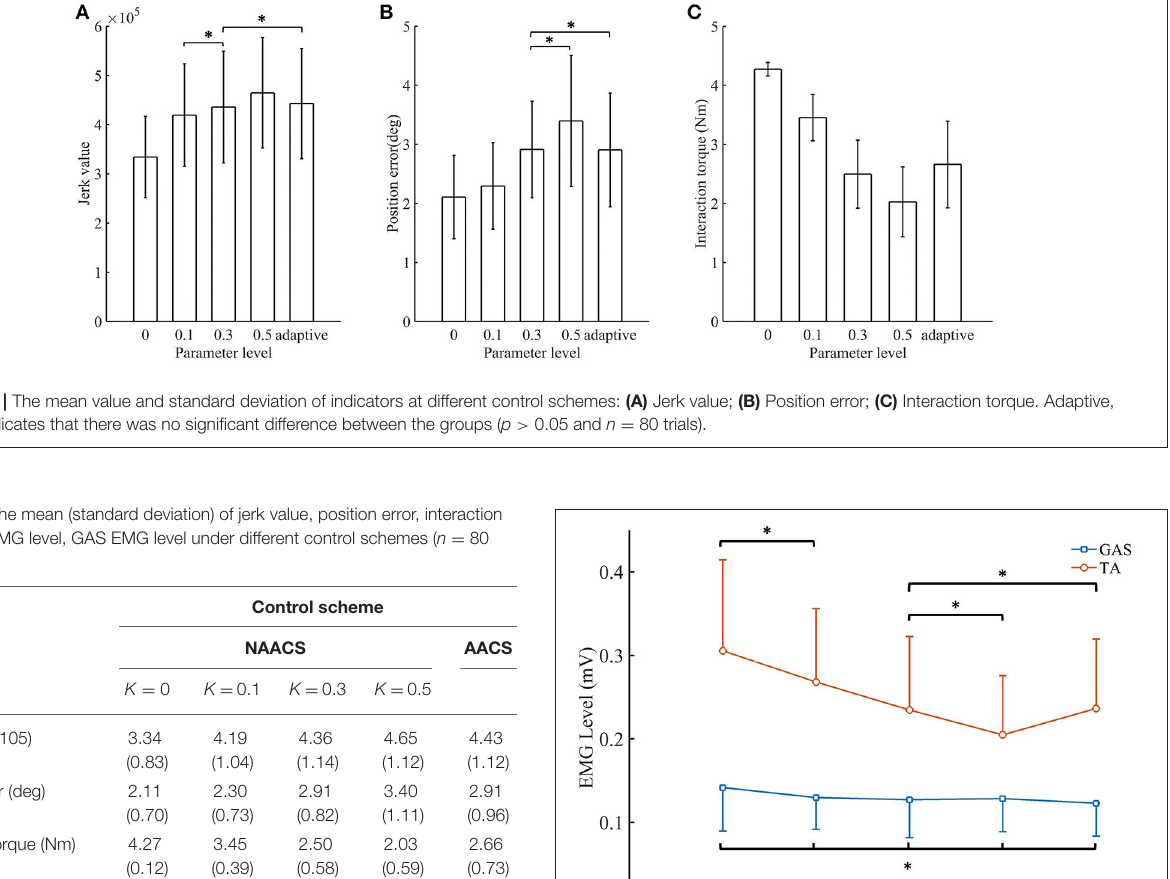
FIGURE 8 | The mean values and standard deviation of TA’s EMG level and GAS’s EMG level. Adaptive, AACS. *indicates that there was no significant difference between the groups ( p > 0.05 and n